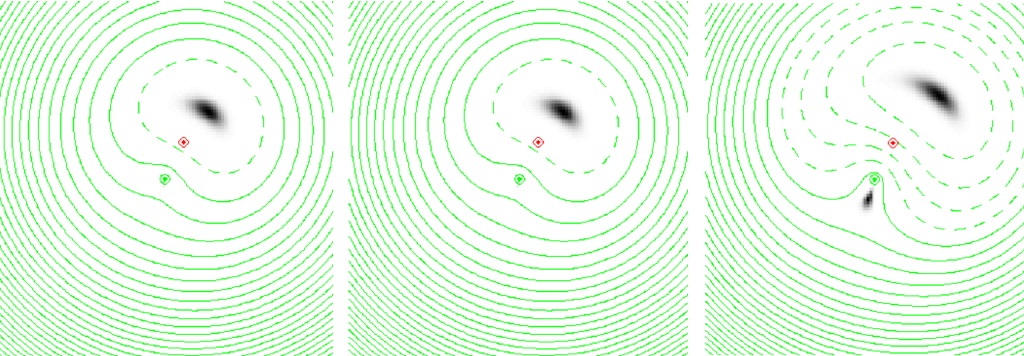
Figure 3: Illustration of a Fermat surface for a source (red symbol) close to the line of sight to a galaxy (green symbol). In each case the appearance of the images to the observer is shown by a greyscale, and the contours of the Fermat surface are given by green contours. Note that images form at stationary points of the surface defined by the contours. In the three panels, the mass of the galaxy, and thus the distortion of the Fermat surface, increases, resulting in an increasingly visible secondary image at the position of the saddle point. At the same time, the primary image moves further from the line of sight to the source. In each case the third image, at the position of the Fermat maximum, is too faint to